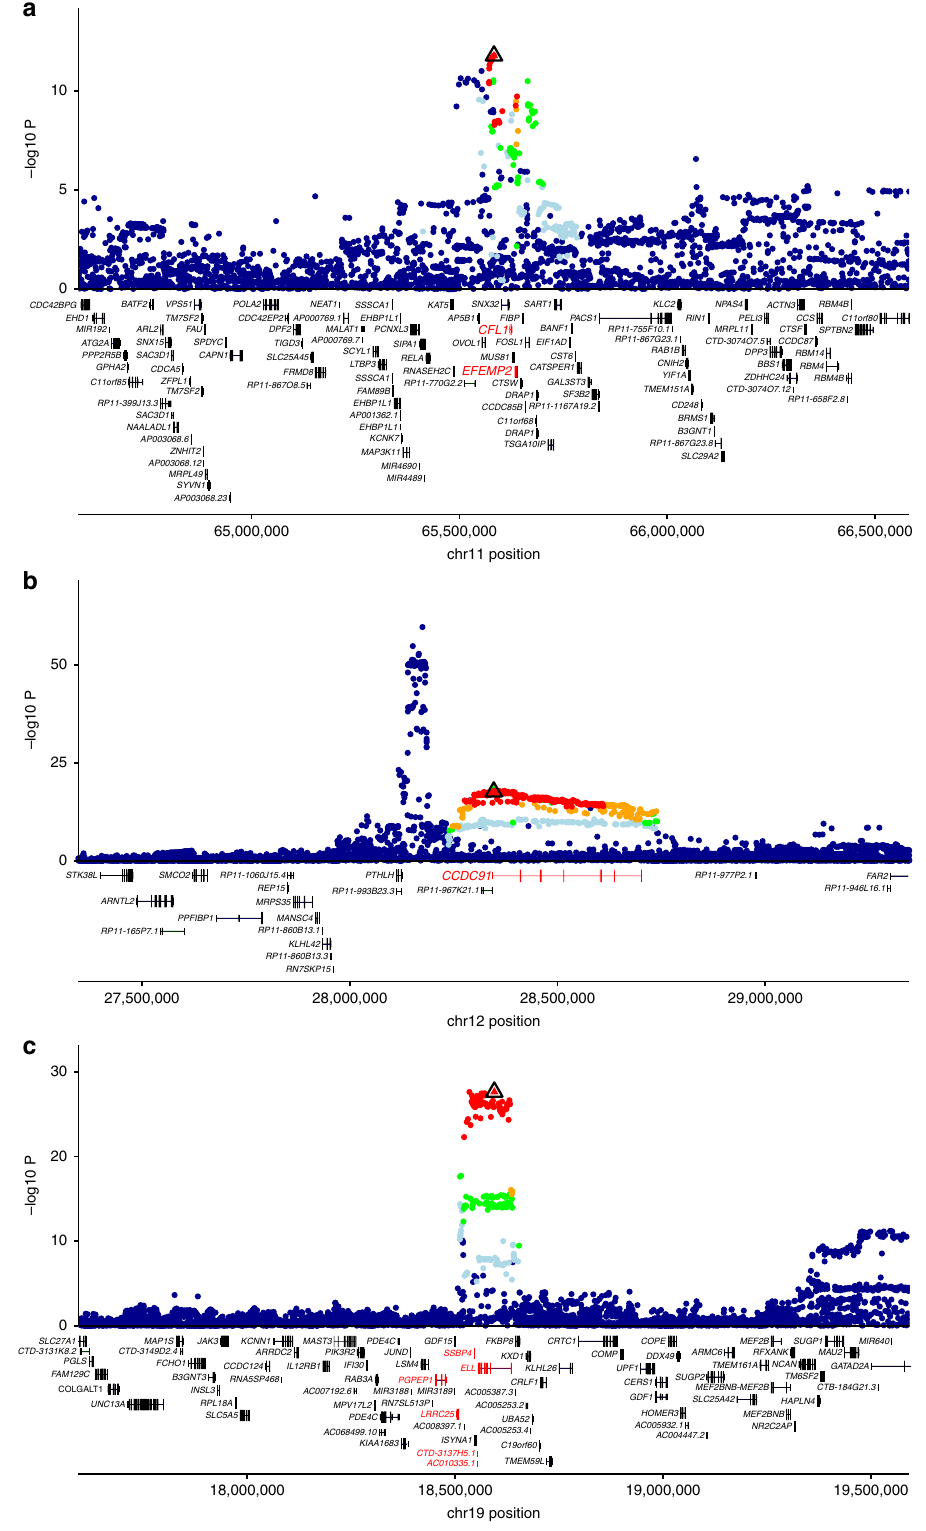
obtained when considering whole-blood transcriptome prediction models based on data from the GTEx consortium (Supplementary Data 7). Overall, these results indicate very good agreement between the directional effect of gene expression on disease risk obtained using information from individual or multiple